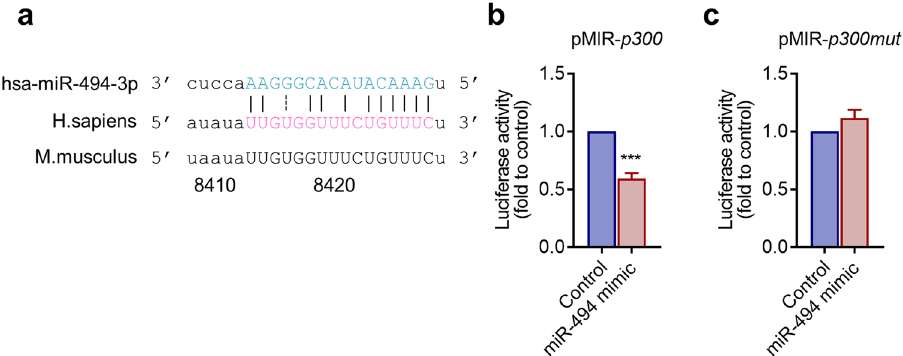
Figure 5. p300 mRNA is a target of miR-494-3p. ( a ) The multiple alignments of hsa-miR-494-3p sequence, and 3 ′ -UTR of p300 mRNA from human and mice. The seed region of miRNA and putative target sequences in p300 genes are shown in capital letters. ( b,c ) Luciferase reporter assays. Luciferase reporters containing the p300 wild- type ( b ) or mutant 3 ′ -UTR ( c ) were transfected along with miR-494-3p mimic or scrambled sequence control into MyoD-hiPSCs at day 2 after myogenic induction and analysed 2 days later. n = 5. *** p < 0.001 versus